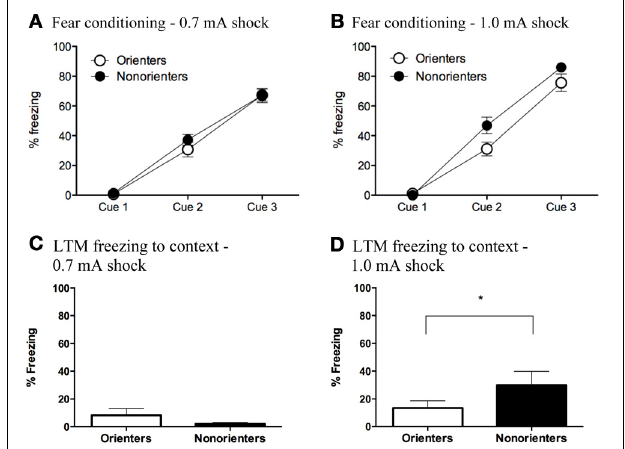
FIGURE 3 | (A,B) Freezing during fear conditioning with a 0.7mA and 1.0mA footshock. (A) Orienters and Non-orienters showed no differences in freezing during conditioning when the US was a 0.7mA footshock ( p = 0 . 49). (B) Non-orienters froze significantly more than Orienters during fear conditioning when the US was 1.0mA footshock ( p = 0 . 04). Each conditioning session involved three CS-US pairings. ( C,D ) Contextual freezing 24h after fear conditioning to either a 0.7 or 1.0mA footshock. (C) There were no significant differences between Orienters and Non-orienters in freezing to the fear conditioning context when the US was 0.7mA footshock ( p = 0 . 09) and overall context freezing was extremely low.